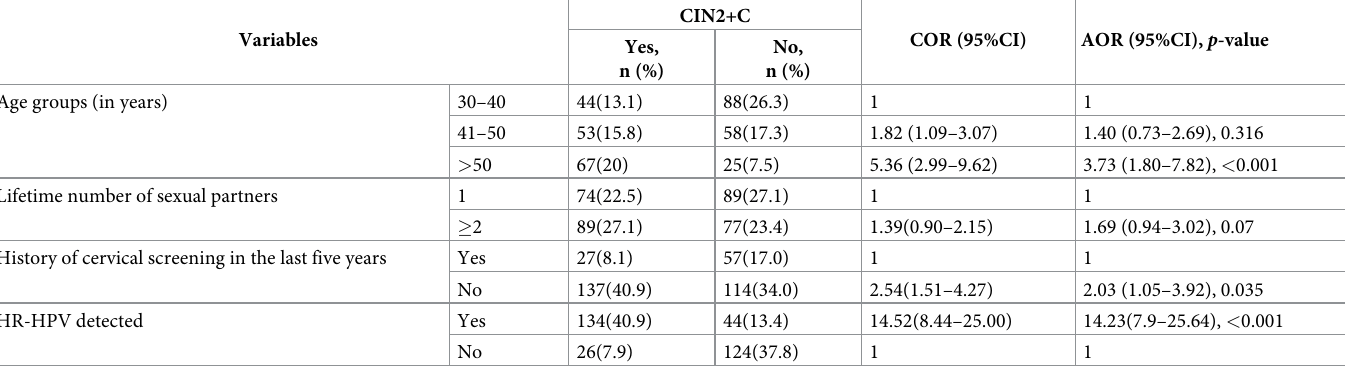
Table 3. Factors associated with high-grade and cancerous lesions